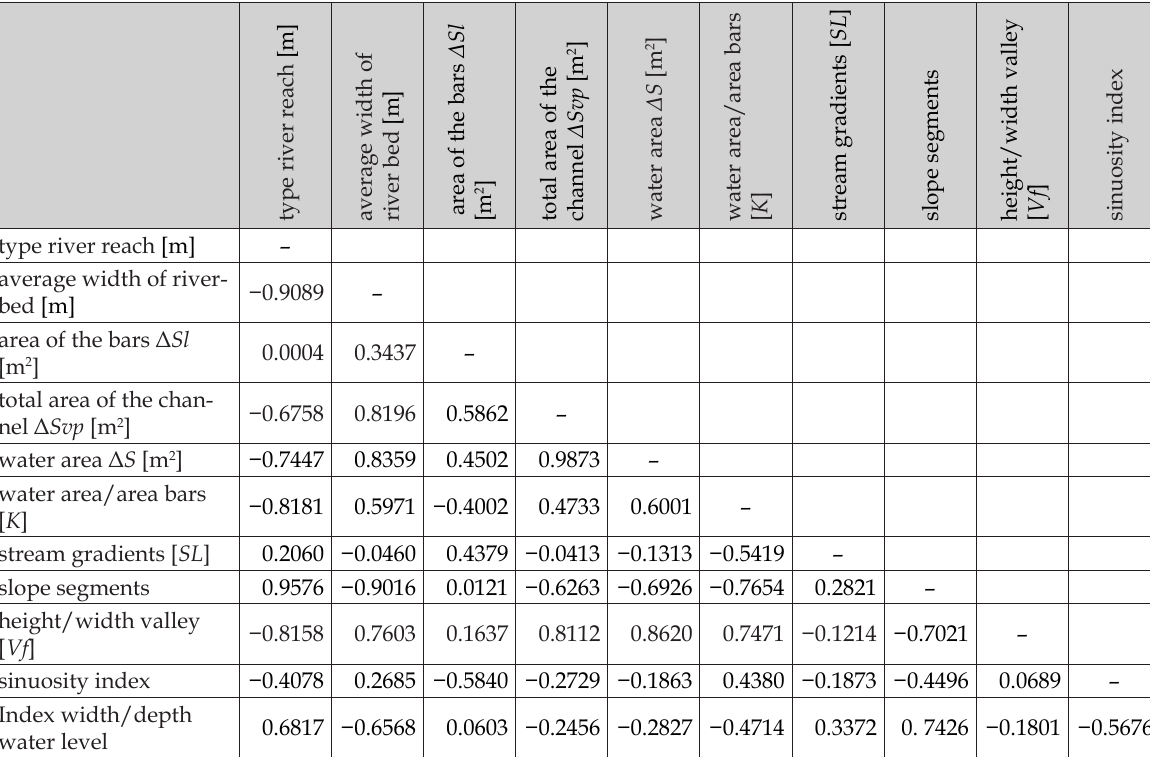
Table 2. Correlation matrix of the individual Oľšava flow parameters in the segments of the mapped